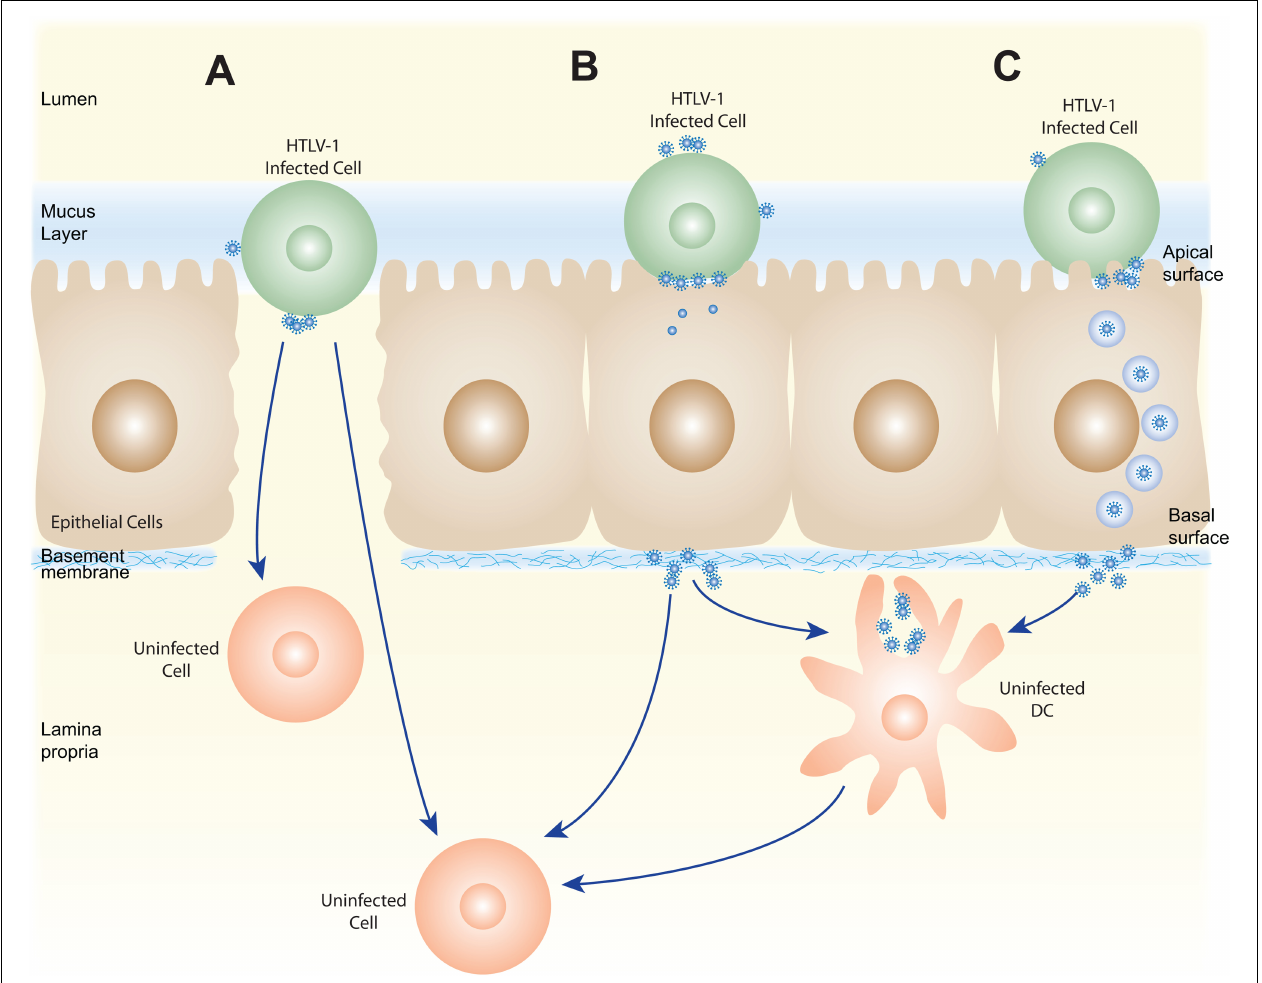
FIGURE 2 | Schematic of several possible pathways for HTLV-1 transmission via breast milk. HTLV-1-infected cells present in breast milk (T cells, macrophages, and/or epithelial cells) could transmit the virus across the oral or gastrointestinal mucosa in several ways.The HTLV-1-infected cells could cross the barrier at positions where the mucosa are disrupted (A) or by transmigration across the epithelial barrier (not shown). HTLV-1 could then be passed by cell–cell transmission to the target cells present in the lamina propia (T cells, macrophages, DC/Langerhans) or in the draining lymph nodes.